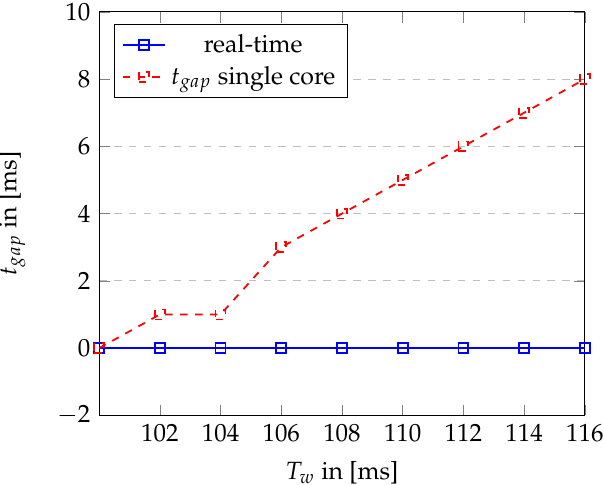
Figure 4. t gap calculated for every timestamp in the scenario depicted in Figure